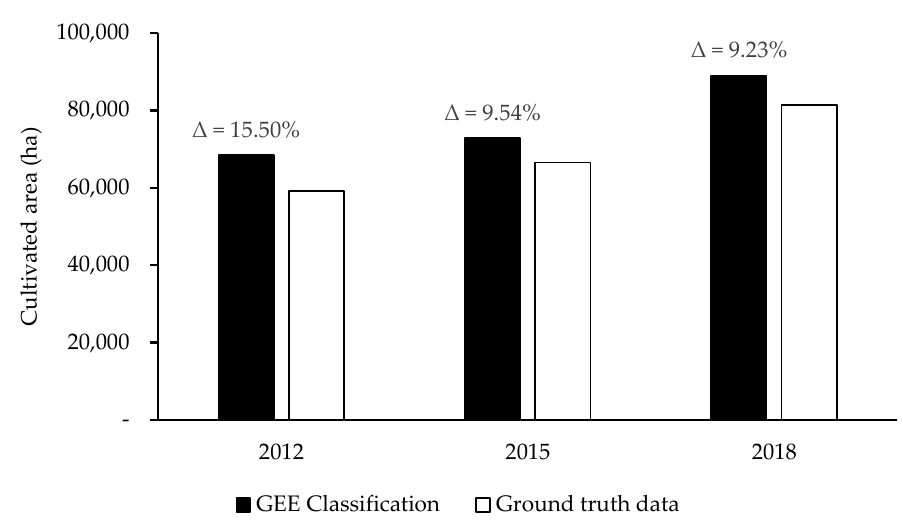
Figure 3. Comparison between cultivated area derived from remote sensing data (classification results) and from ‘Serviços Distritais de Actividades Económicas (SDAE)’ (Local agrarian data). The percentage of overestimation of Google Earth Engine (GEE) classification relative to ground truth data is provided for each year.